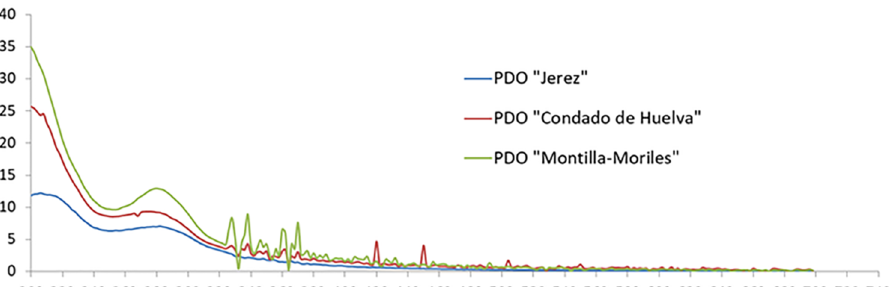
Figure 1. Typical UV-Vis spectra of vinegars.